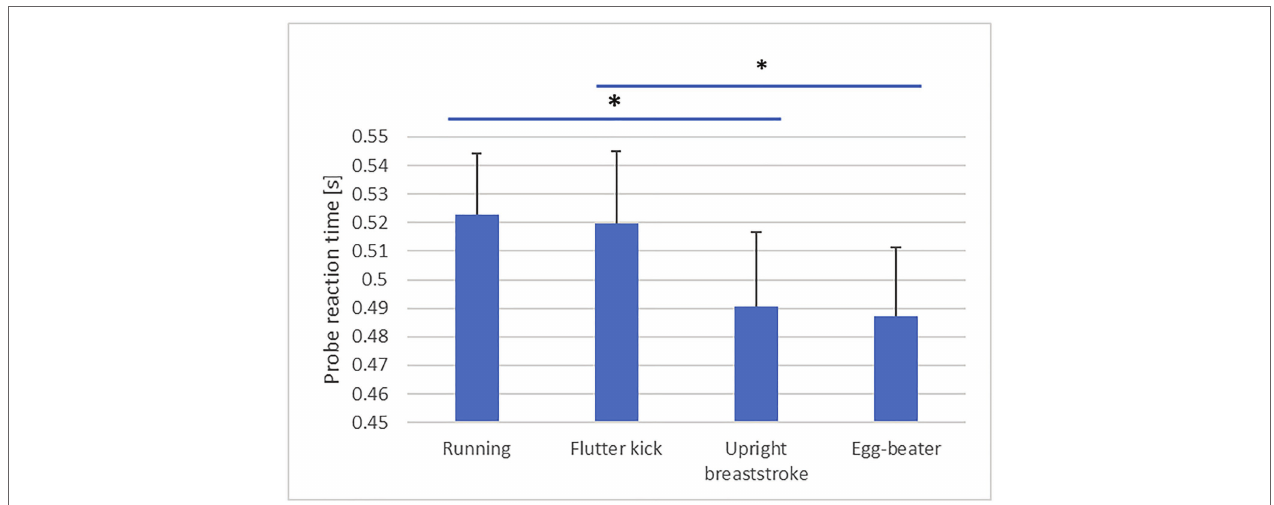
FIGURE 1 | Probe Reaction Time (PRT) during four treading water techniques in skilled treaders – means and SEs. * Denotes significant difference between techniques ( p corrected < 0.05).